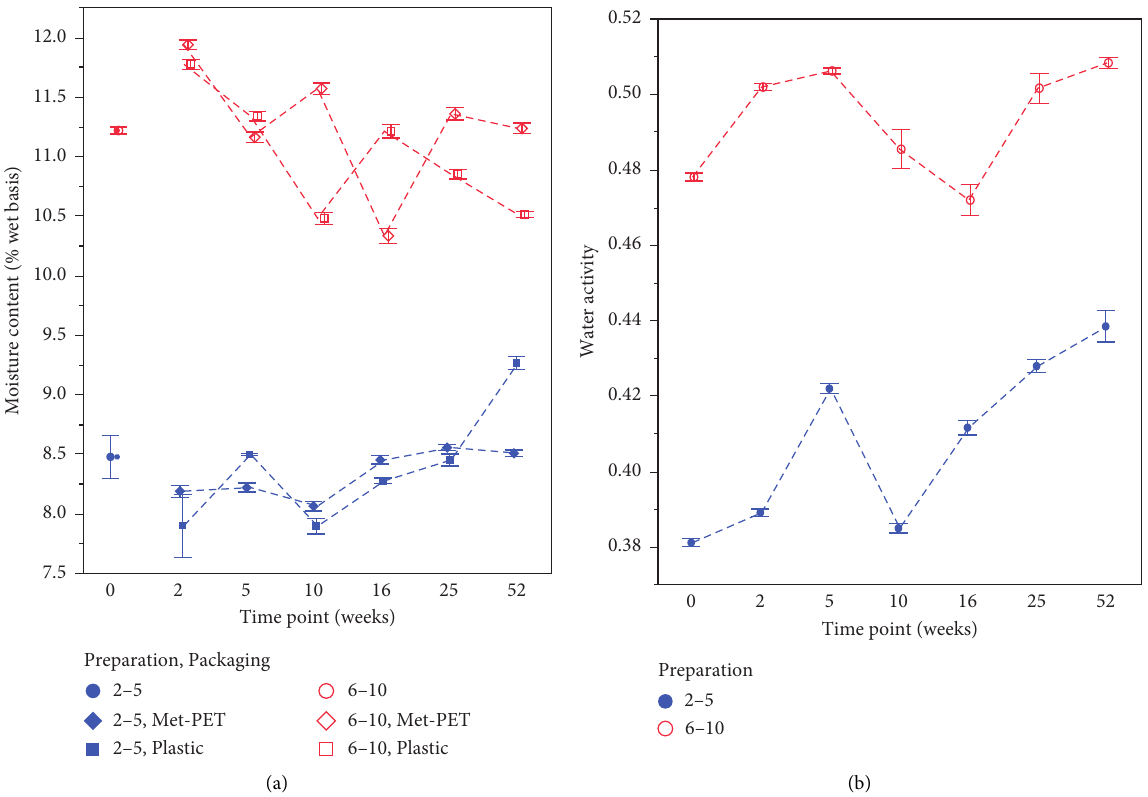
Figure 1: Mean (a) moisture content and (b) water activity of the persimmon chips over the 1-year course of the storage study. Packaging had a significant ( p < 0 . 05) effect on moisture content, so this variable is split out in panel (a). However, Packaging did not have a significant effect on water activity, so Packaging is not specified in panel (b). Each error bar is constructed using 1 standard error from the